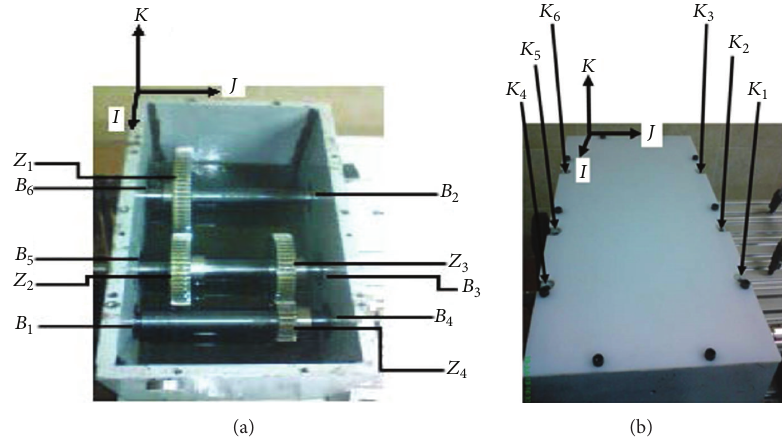
Figure 4: (a) The internal configuration of the gearbox; (b) positions for accelerometers.